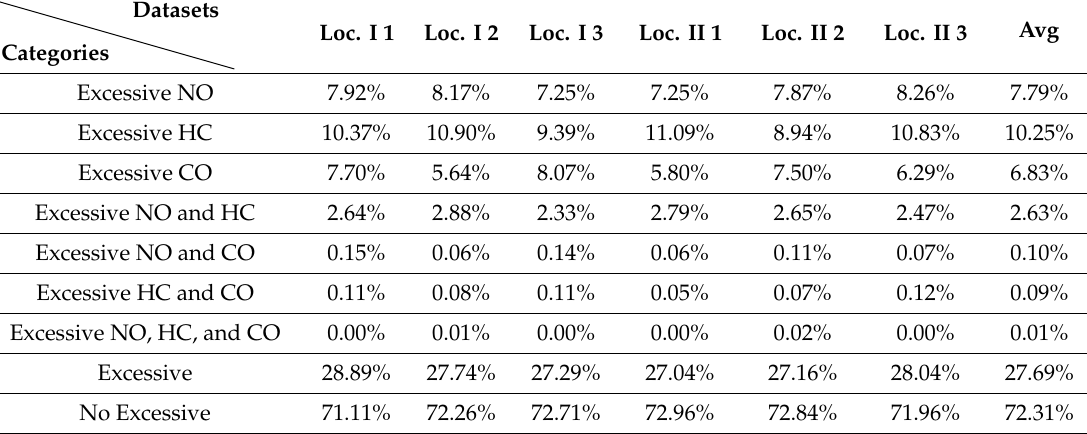
Table 4. The results of the experiment for detecting the rate of exceeded